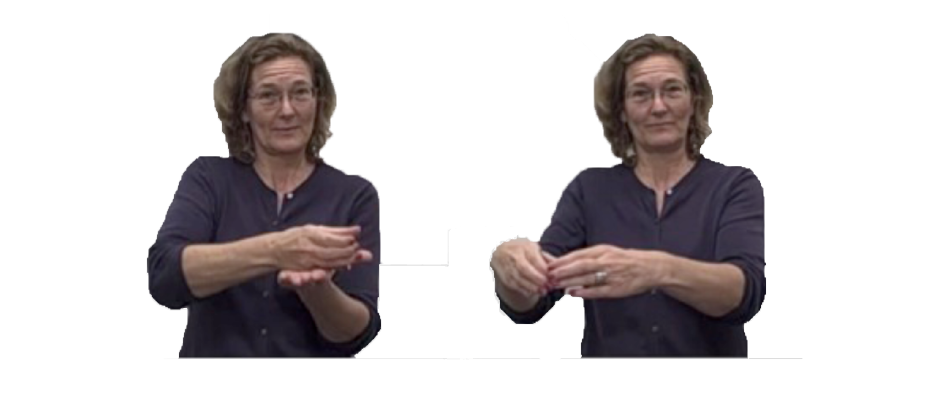
Figure 2 coord-shift : cup coord-shift